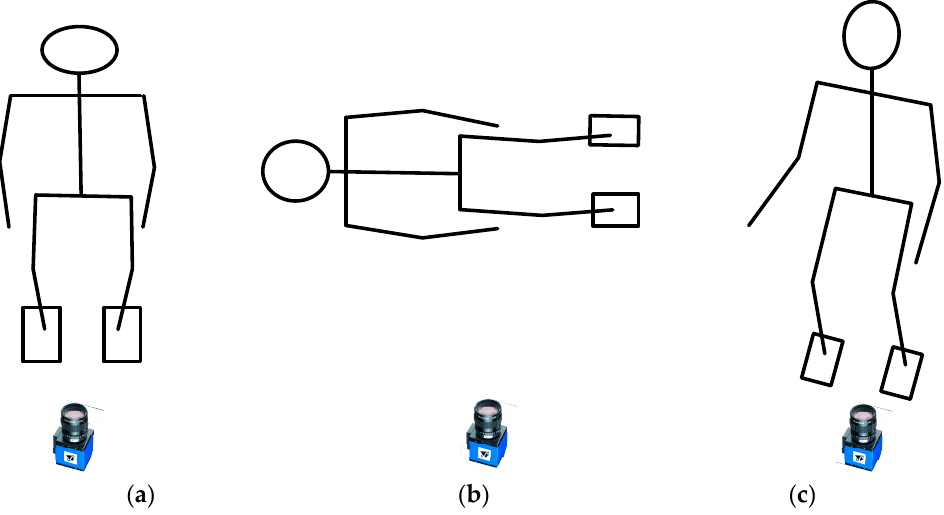
Figure 2. The 3D humanoid robot model.